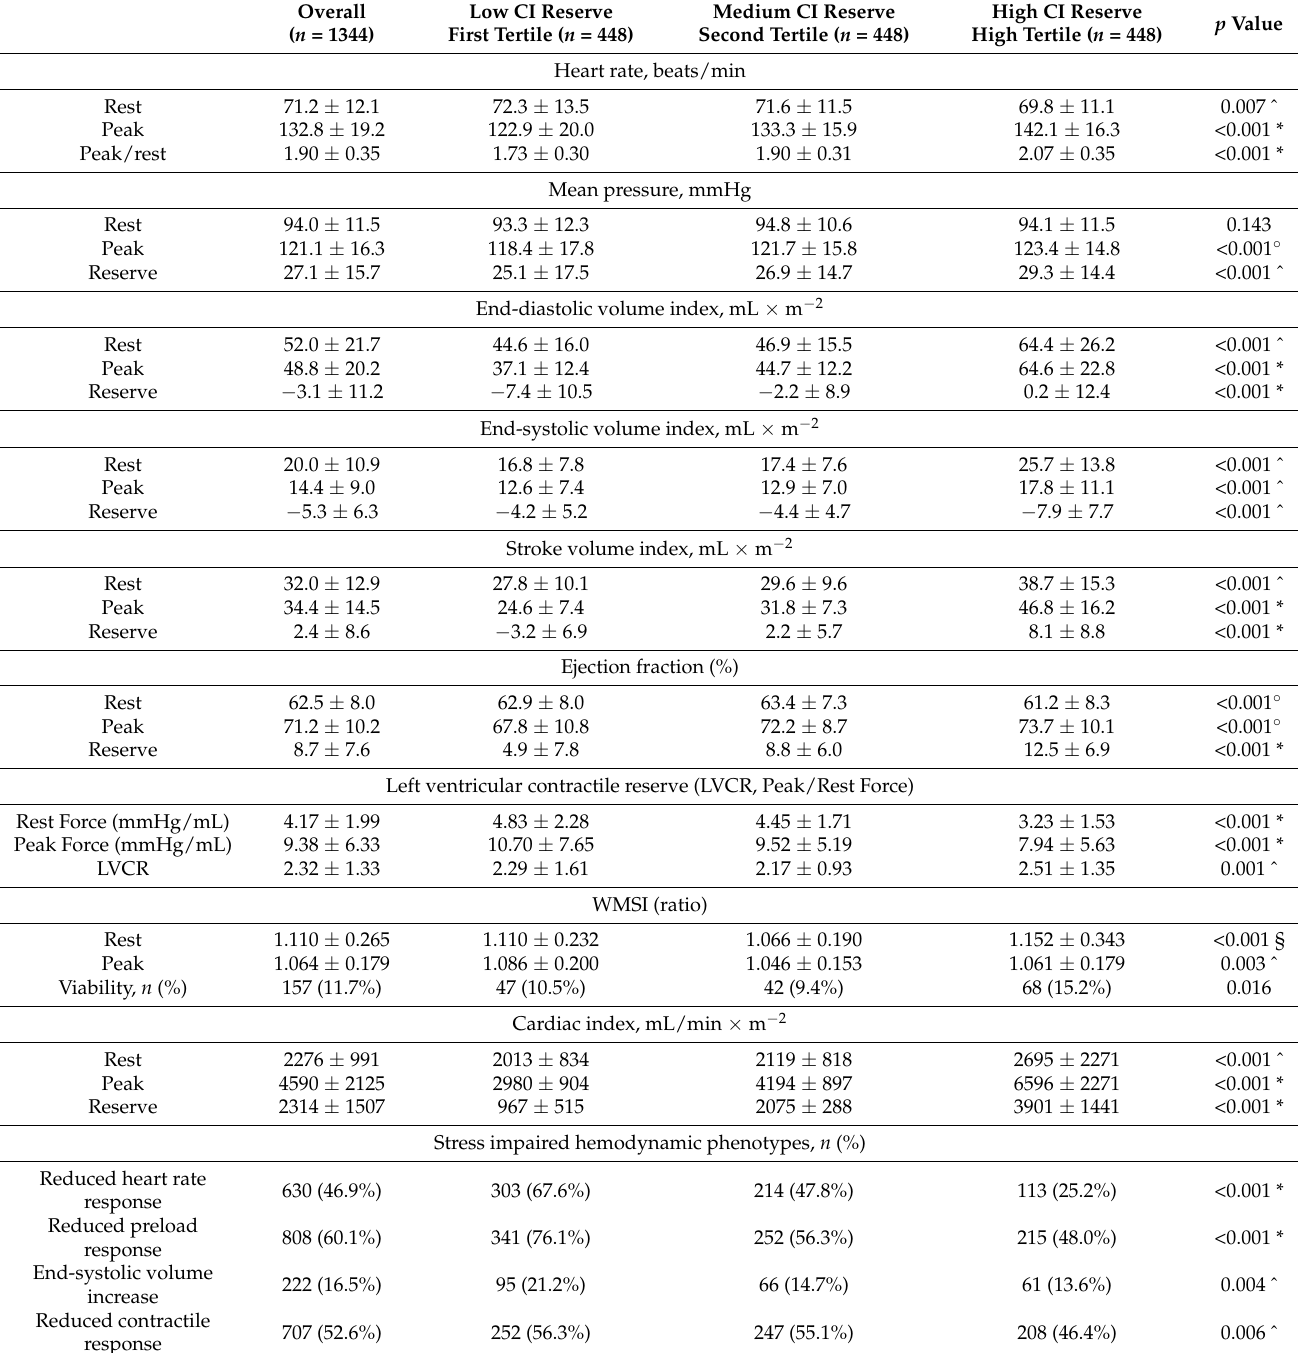
Table 2. Hemodynamic, rest and stress echo findings according to CI